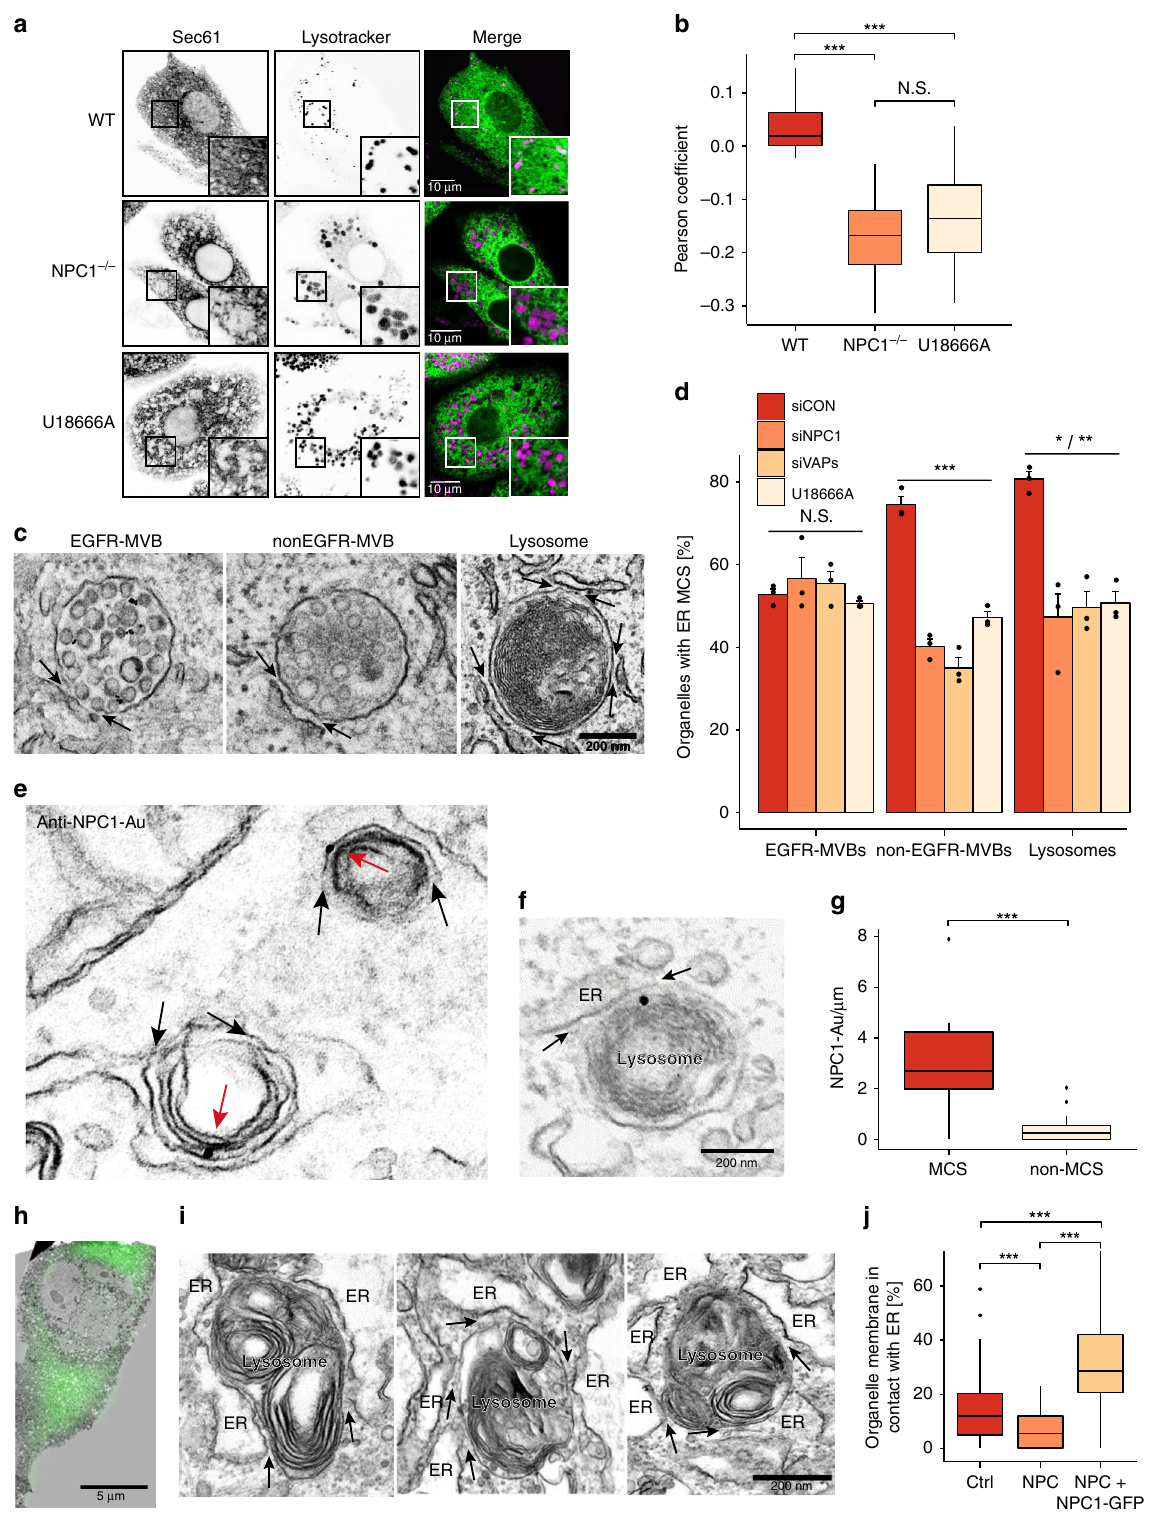
NPC1 and Gramd1b (Fig. 2a, b) that could also be detected by IP of endogenous proteins (Fig. 2c). This interaction is in fl uenced by the sterol environment, as there was a reduction of Gramd1b coimmunoprecipitated with NPC1 from cells cultured in lipo- protein de fi cient serum (LPDS) compared with those cultured in the presence of full serum (Fig. 2c, d). The expression of both proteins appeared unaffected by the sterol